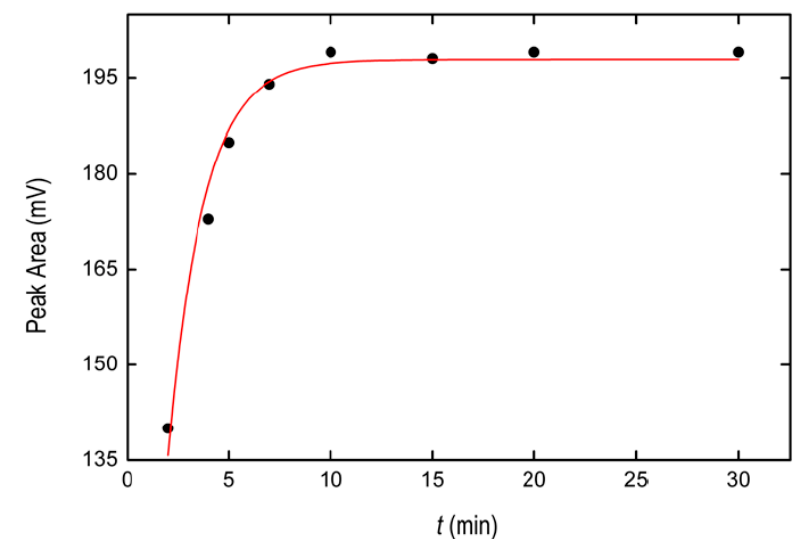
Figure 3. Effect of incubation time at 30 °C on the BPA signal obtained from the IL phase. Solid red line represents the fit to Equation (1).